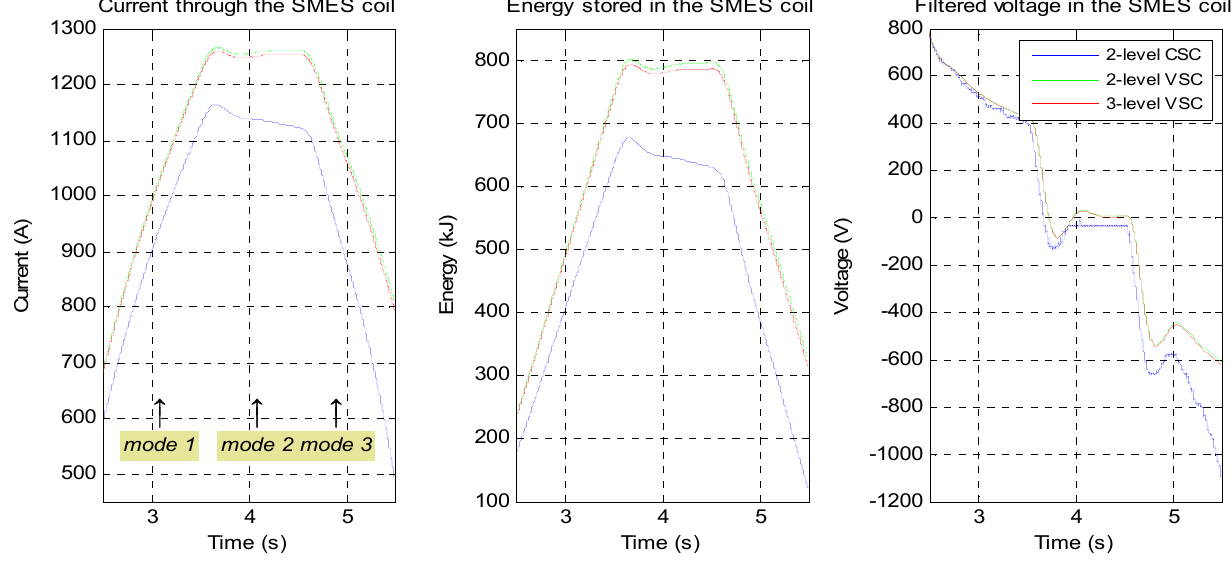
Figure 20. Current and voltage in the superconducting coil in each